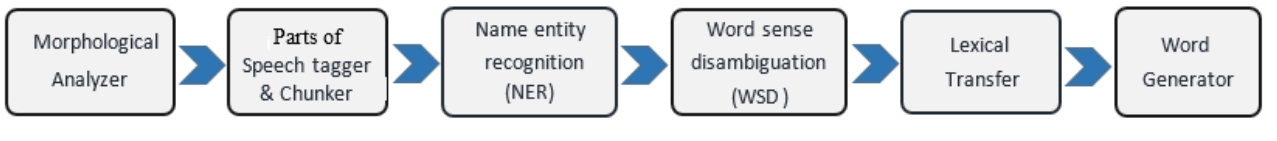
Figure 3. RBMT functional